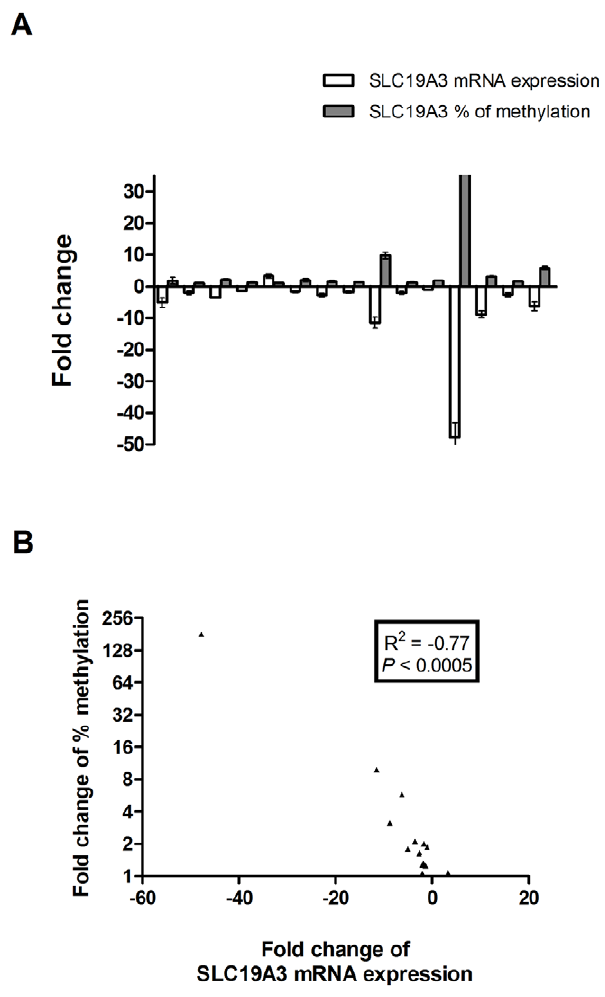
Figure 3. SLC19A3 is frequently down-regulated through promoter hypermethylation in breast cancer. (A) Fold change relationship between SLC19A3 mRNA expression and methylation percentage in those 15 breast cancer patients (mean 6 SD). (B) Correlation analysis of the fold changes between SLC19A3 mRNA expression and methylation percentage (Spearman rank correlation, R 2 = 2 0.77, P , 0.0005).